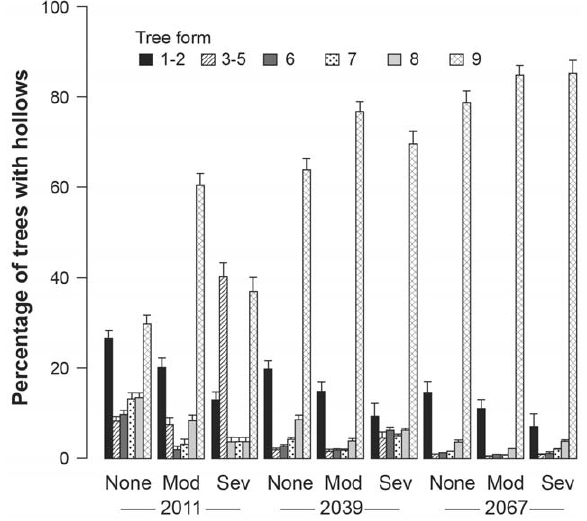
Figure 5. Projected relative composition of forms of large trees with cavities in 2011, 2039 and 2067. The latter date is when existing 72 year old trees will reach 120 years of age and regularly begin developing cavities – see text. This assumes no logging and no further fire on the 156 sites used to make the projection. In addition, we assume there are no changes in moisture